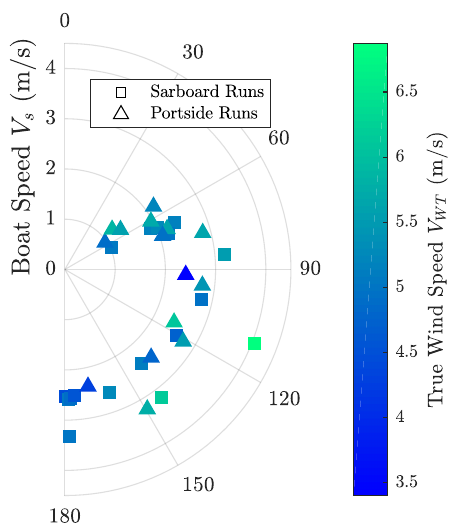
Figure 14. Polar of the kiteboat in the most used configuration (Kite Cabrinha R (cid:13) 12 m 2 , Tether length 50 m, Black daggerboard, Kite attachment point at 2.68 m, No motor). Port side and starboard runs were set together, but marker type (square or triangle) allows the identification.